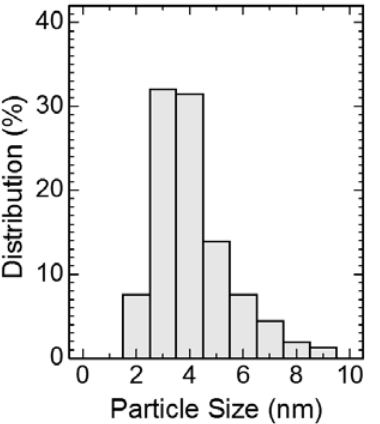
Figure 3. Histogram of the size distributions of the Pt particles on the carbon black.